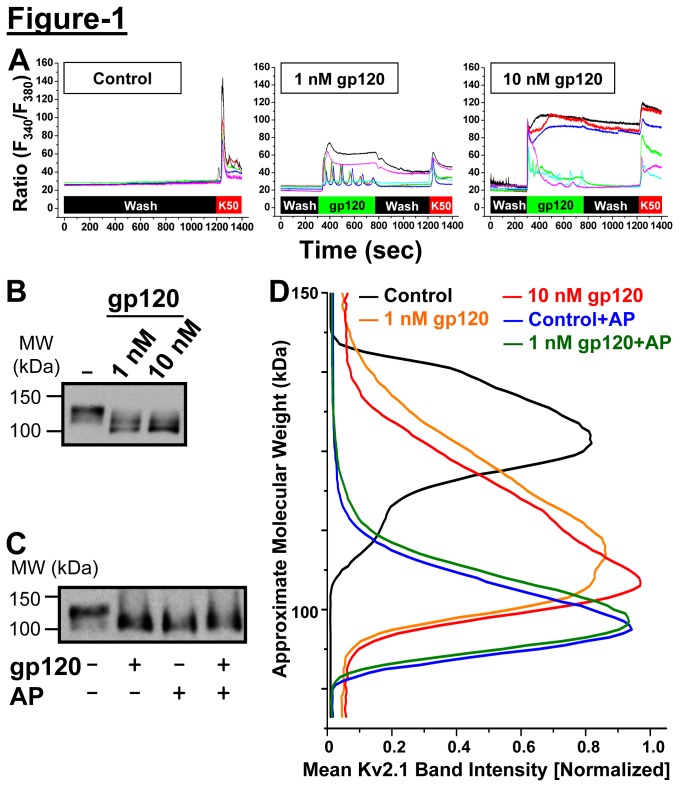
Acute HIV-1 gp120 induces calcium (Ca2+) flux and dephosphorylation of Kv2.1 in hippocampal neurons.
A, Representative traces of ratiometric Ca2+ imaging in cultured rat hippocampal neurons using Fura-2. In the left panel, HH buffer (wash) was perfused over the coverslip, prior to a pulse of 50 mM KCl (K50) to demonstrate depolarization-induced Ca2+ influx in each neuron. Following exposure to 1 nM gp120 (center panel), neurons demonstrate transient or sustained changes in the fluorescence ratio (340: 380 nm), an indicator of increased intracellular Ca2+. This effect was partially washed out upon washing with HH buffer. With 10 nM gp120 (right panel), the magnitude of Ca2+ influx is increased, such that several neurons show sustained elevations in [Ca2+]i that persist for minutes after gp120 perfusion has ended. B, Immunoblot analysis of Kv2.1 phosphorylation levels upon acute gp120 treatment (1 and 10 nM, 30 min) of cultured rat hippocampal neurons, showing increased electrophoretic mobility of Kv2.1 immunoreactive bands in a dose-dependent manner. This apparent decrease in molecular weight can be attributed solely to channel dephosphorylation, since alkaline phosphatase (AP) treatment of samples (shown in C) decreases the molecular weight of the channel protein to the same, minimal level as predicted from the deduced amino acid sequence of Kv2.1. Numbers on the left in panels B & C denote the approximate molecular weight. D, Quantification of the extent of Kv2.1 phosphorylation upon gp120 exposure as shown in panels B & C). Densitometric analysis of Kv2.1 immunoreactive band intensities at molecular weight range of ~90 to ~150 kDa (see methods for details), showing phospho-Kv2.1 with peak intensity at ~130 kDa and dephospho-Kv2.1 with peak intensity at ~100 kDa. Data are presented as mean (n = 4-5 for each group).